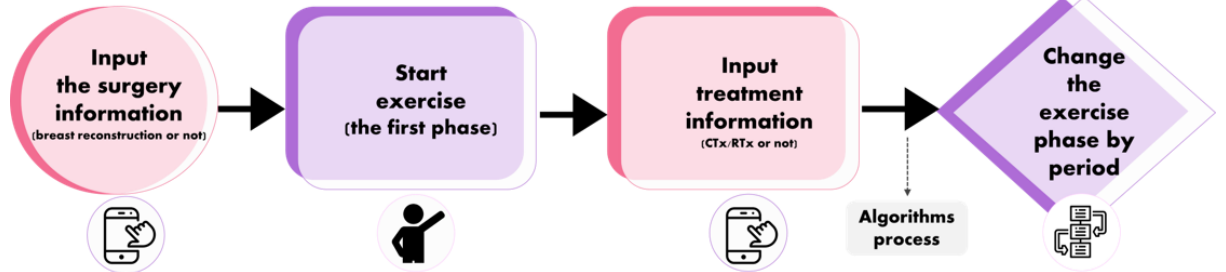
Figure 4. Process of applying the personalized arm and shoulder exercise program. CTx: chemotherapy; RTx: radiation therapy.